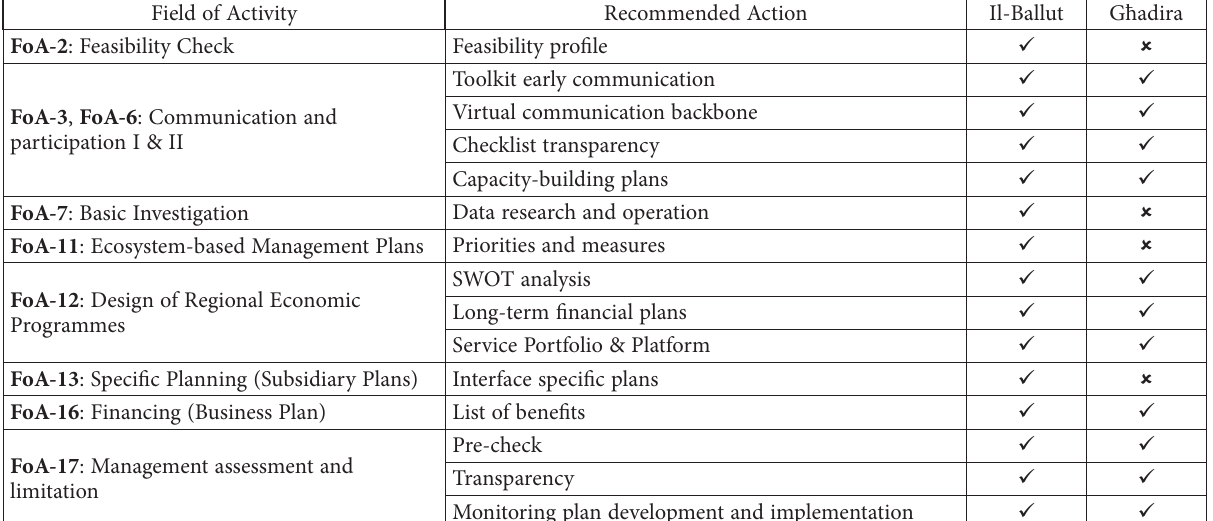
Field of Activity